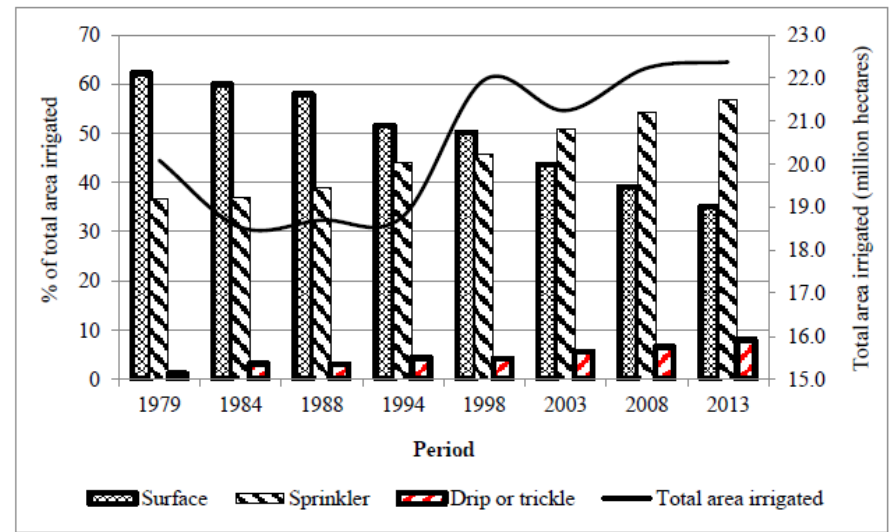
Figure 4. Area of land in the Unites States irrigated using different methods. (Plotted from data obtained from: USDA 1990, Table 4; USDA 1999, Table 4; USDA 2006, Table 4.6.1; USDA 2009, Table 4; USDA 2014, Table 28) [46].